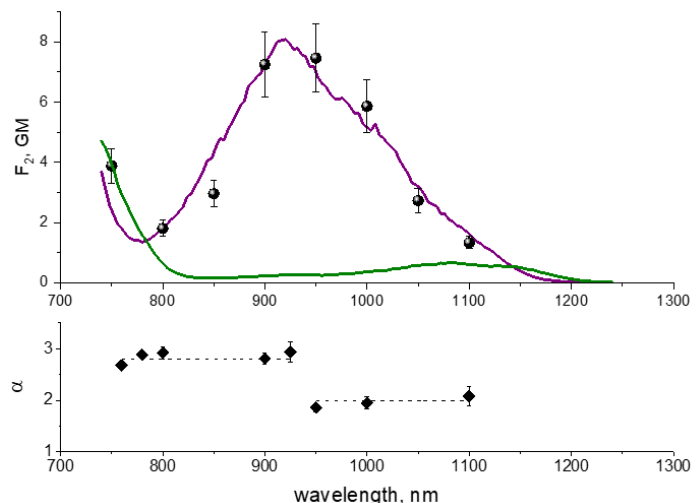
Figure 6. Top: Two photon action spectra of jREX-GECO1 measured in Ca 2+ -free (green line) and Ca 2+ -bound (purple line) states in buffer [35] and in E. coli cells (normalized to Ca 2+ -bound spectrum at 900 nm). Bottom: Power exponent of the bleaching rate power dependence as a function of wave- length.